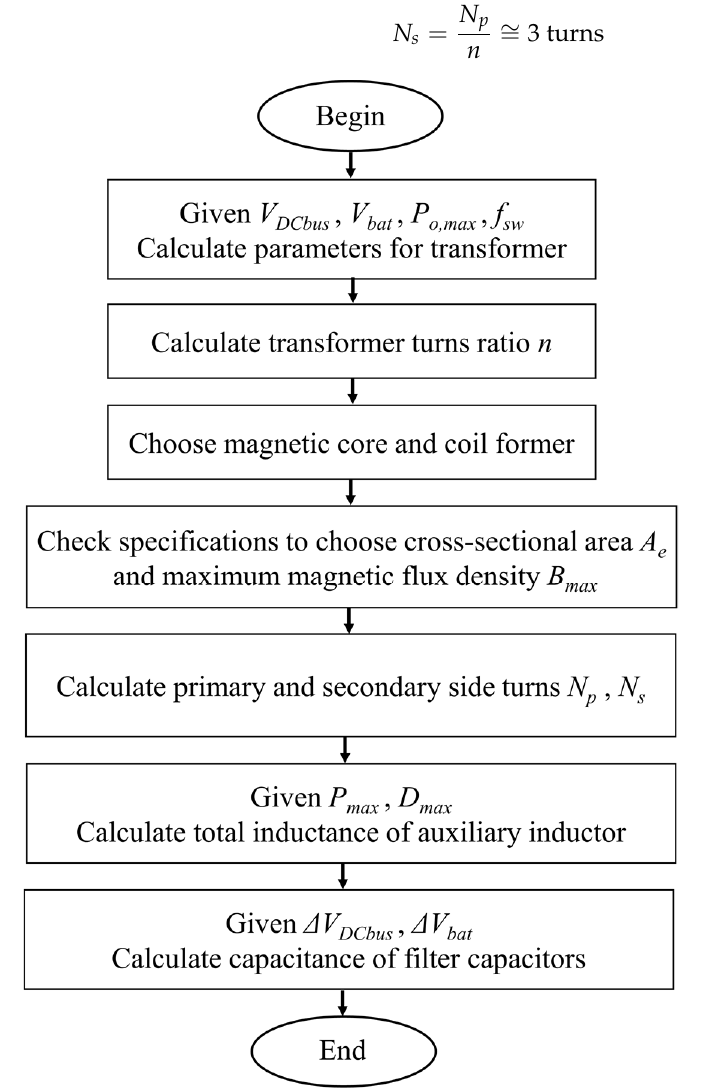
Figure 10. Design flow chart for energy storage components.